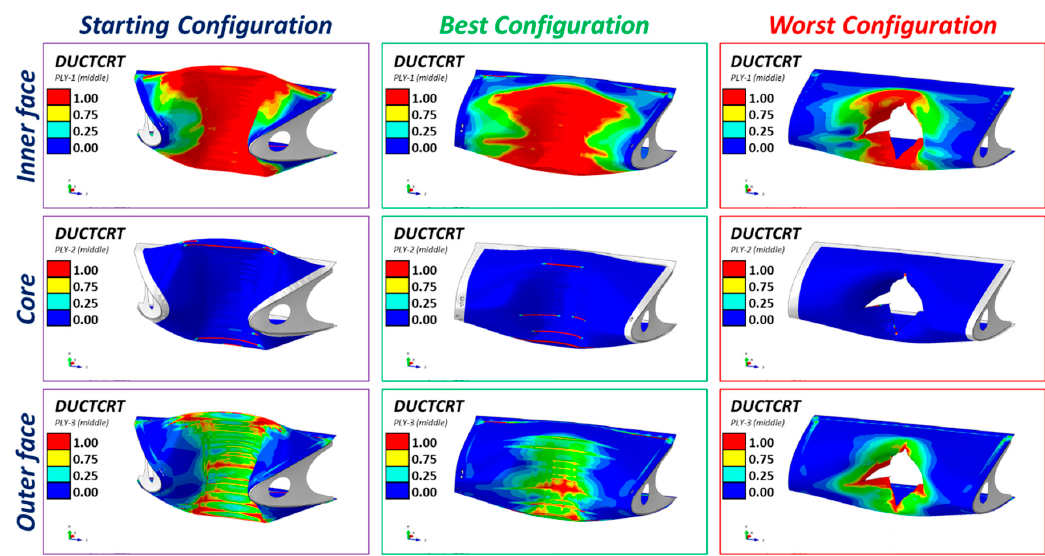
Figure 15. Ductile criteria for inner and outer face and core for all investigated models.